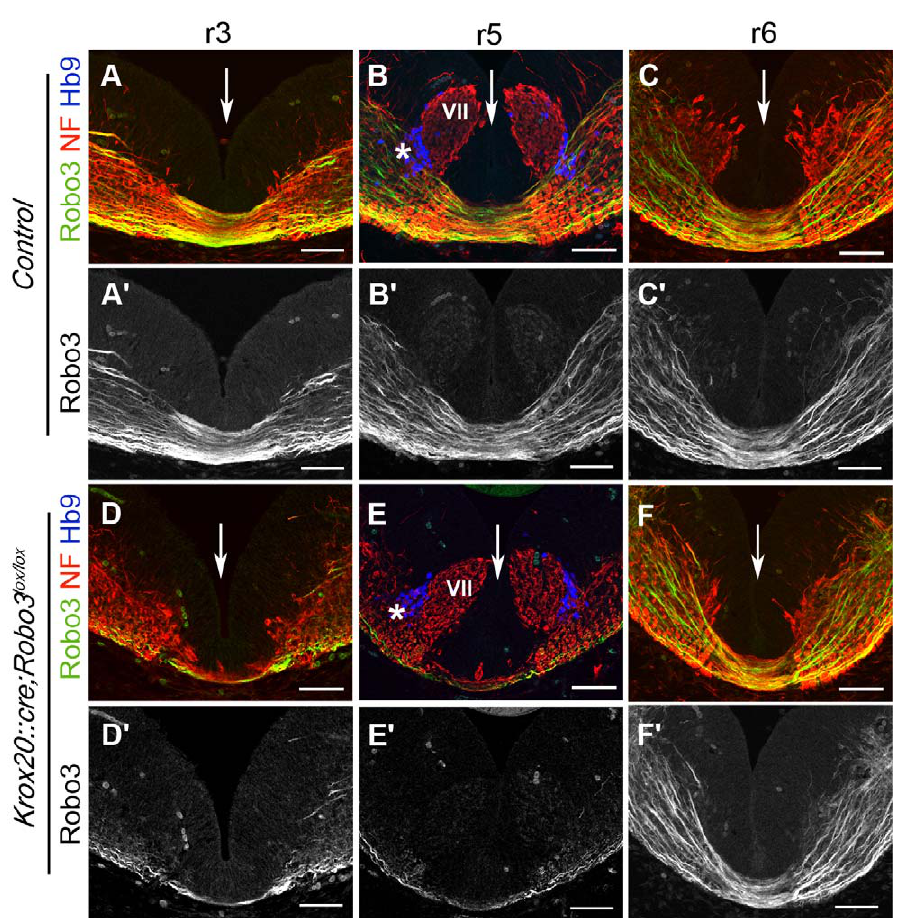
Figure 2. Rhombomere-specific deletion of commissures. Coronal sections at the level of r3, r5, and r6 of E11 control (A–C 9 ) or Krox20::cre;Robo3 lox/lox (D–F 9 ) embryos immunostained with antibodies against Robo3, neurofilament, and Hb9. The midline is indicated by an arrow, and the Hb9-positive abducens motor neurons by an asterisk. In r3 and r5, there is an almost complete absence of Robo3 and neurofilament-positive commissural axons in Krox20::cre;Robo3 lox/lox (D–E 9 ) compared to controls (A–B 9 ). The density of neurofilament-positive axons is also strongly reduced. By contrast, there is no obvious reduction of commissural axons or Robo3 expression in r6 (C, C 9 , F, and F 9 ). Note that at E11, abducens shape and position are not altered in mutants compared to controls (see Figure 3 for later stages). VII, migrating facial neurons and facial nerve. Scale bars represent 60 m m. selectively express GFP in the VI and hypoglossus (XII) somatic motor neurons (Figure 3E). Analysis of Hb9::GFP labeling and guidance molecules, Netrin1 , Sonic Hedgehog ( Shh ), Slit1 , Slit2 , and Slit3 was not perturbed in r3 and r5 (Figure S3; n = 2/2). immunostaining or in situ hybridization with motor neuron markers (Hb9, BEN/SC1, Islet-1, ChAT, CGRP) revealed that, from E12, the shape and mediolateral position of the abducens motor nuclei were slightly altered in Robo3 2 / 2 ( n = 16/16) and Krox20::cre;Robo3 lox/lox mice ( n = 9/9; Figure 3F–3I and Figure S4). However, abducens motor axons still selectively projected to the lateral rectus muscle ( n = 3/3 in Robo3 2 / 2 and n = 2/2 in Krox20::cre;Robo3 lox/lox ; Figure 3J–3L). GFP-positive abducens axons were never found to cross the midline, suggesting that, as in controls, the projection remains ipsilateral. In addition, the numbers of Hb9-positive VI neurons were similar in Krox20::cre; Robo3 lox/lox and control mice (211 6 28 and 205 6 19 neurons per nucleus, respectively, p = 0.8, n = 4 animals for each genotype; Student t -test with Mann-Whitney hypothesis, see Materials and